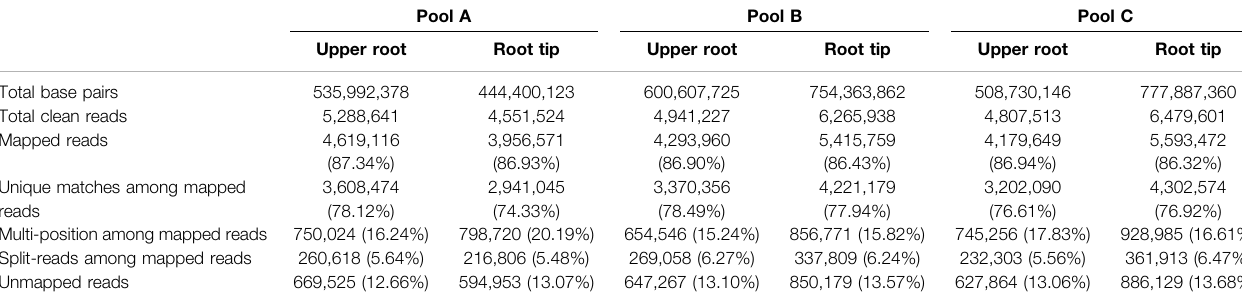
TABLE 1 | Summary of MACE alignment statistics in six libraries mapped to the reference genome.